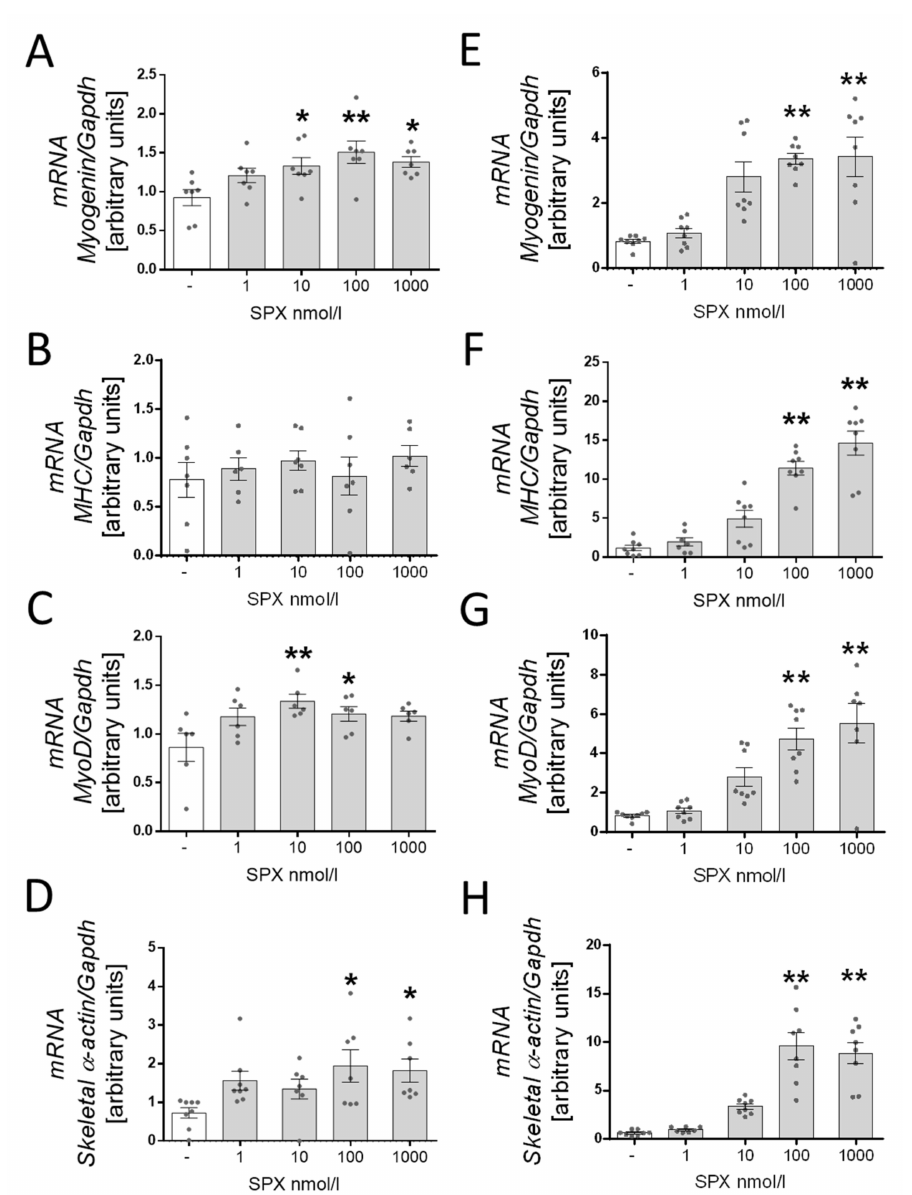
Figure 3. The effect of SPX on the mRNA expression of myogenin ( A ), Myh4 ( B ), MyoD ( C ) and skeletal α -actin ( D ) after 2 days of differentiation and myogenin ( E ), Myh4 ( F ), MyoD ( G ) and skeletal α -actin ( H ) after 6 days. Values are presented as mean ± standard error of the mean (S.E.M.) ( n = 6, 8). Statistically significant differences are marked for p < 0.05 (*) and p < 0.01 (**) compared to the corresponding